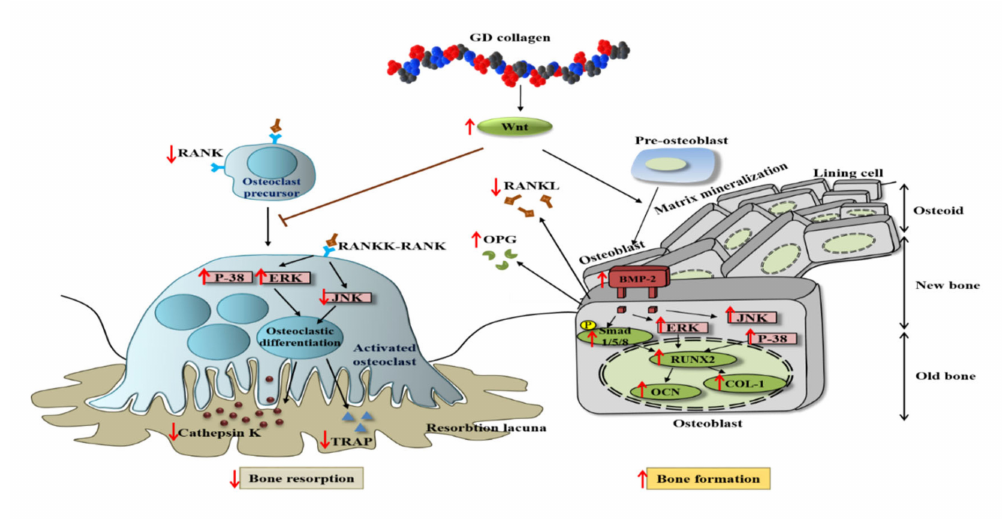
Figure 8. Scheme of GD collagen effects on osteoblastogenesis and osteoclastogenesis signaling